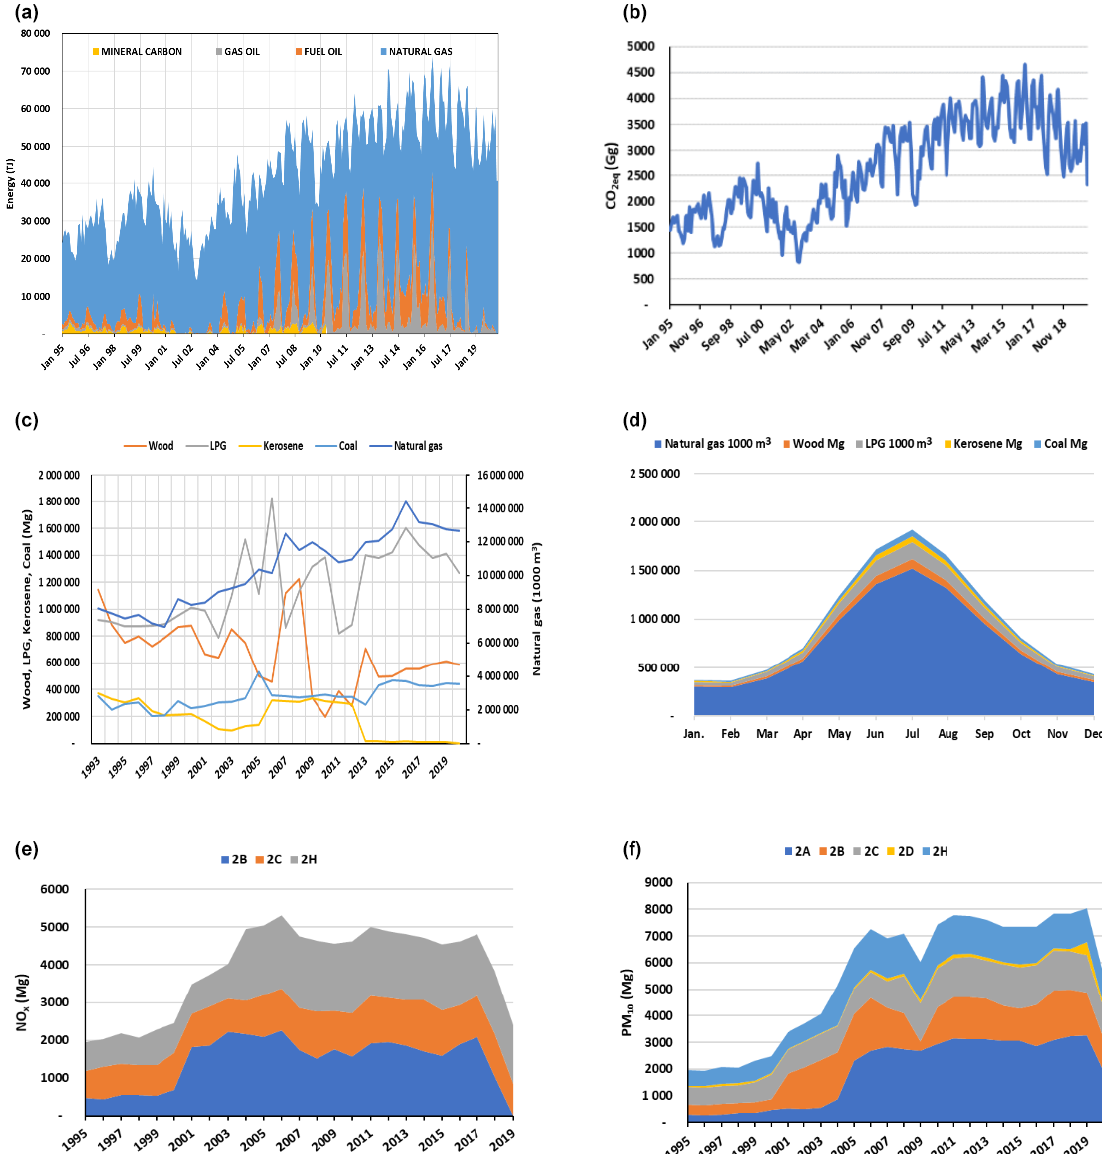
Figure 3. (a) Evolution of monthly energy consumption by thermal power plants. (b) GHG emissions evolution (in terms of CO 2eq Gg) from energy consumption at thermal power plants. (c) Monthly fuel consumption for residential and commercial sectors. (d) Seasonal average fuel consumption for residential and commercial sectors for the period 1995–2019. (e) Annual NO x emissions (in metric tons) from manufacturing activities. (f) Annual PM 10 emissions (in metric tons) for manufacturing activities. Ref. manuf. codes: 2A: cement,